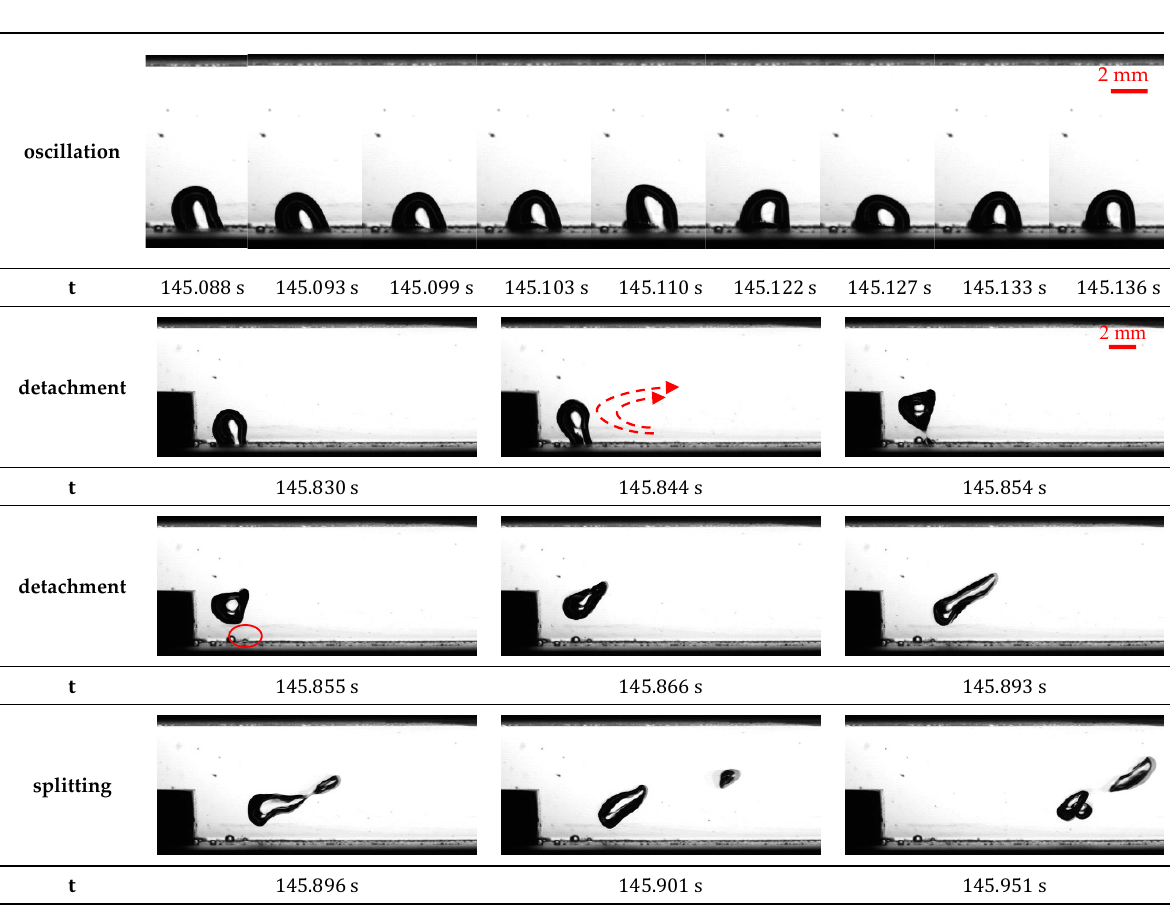
t (cid:3404) 30 ms Figure 15. Top view when Re = 11,000. Figure 16 shows the change of the bubble centroid position ( Center-X ) with Reynolds number in the experiment. It is found that the bubble position does not change signifi- cantly and does not show certain regularity. This is due to the small size of the experi- mental pipe, the small range of variation of the bubble position, and the fact that the meas- ured data of the bubble center-of-mass position is an average value, resulting in the ina- bility to accurately measure the variation pattern of the bubble position in the experiment. Meanwhile, Figure 16 indicates the variation of the equivalent volume diameter ( d e ) of bubbles in the backward-facing step flow field at different Reynolds numbers. When the Reynolds number increases from 2300 to 4000, the average equivalent volume diameter main flow direction